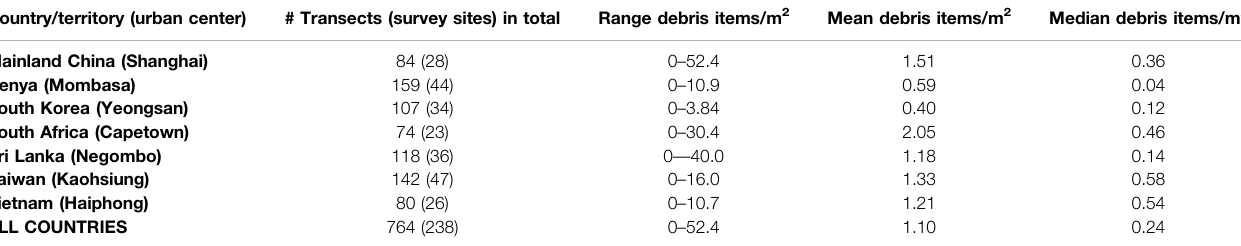
TABLE 2 | Range, mean, and median items per meter squared found on inland surveys in each country/territory. Country/territory (urban center) # Transects (survey sites) in total Range debris items/m